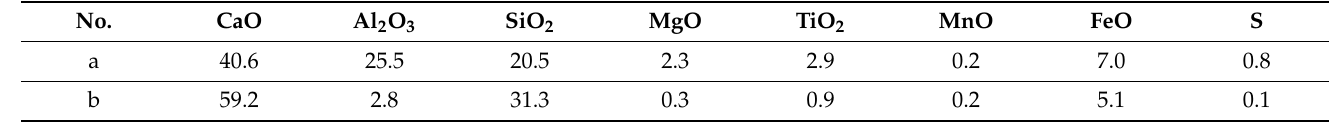
( b ) Figure 10. CaO-Al 2 O 3 -SiO 2 ternary phase diagrams.( a ) experimental data, ( b ) average data The CaO-Al 2 O 3 -SiO 2 and CaO-SiO 2 inclusions’ compositions at different stages were projected into ternary phase diagrams of CaO-Al 2 O 3 -SiO 2 , as shown in Figure 10. Since the inclusion composition of the industrial sample is distributed dispersedly (Figure 10a), the average composition of inclusions during different stages is shown in Figure 10b. The in- itial composition of the LF entry is located in the 2CaO ∙ SiO 2 region, and with the refining processing from LF → VD → TD → final products, the average composition moved from the 2CaO ∙ SiO 2 region to the 2CaO ∙ Al 2 O 3 ∙ SiO 2 region (Gehlenite) and eventually returned to the 2CaO ∙ SiO 2 region (Ca 2 SiO 4 ). First, additive lime during the BOF tapping process brought CaO into molten steel, and it met the primary deoxidization product SiO 2 and formed 2CaO ∙ SiO 2 . When Ti-Fe alloy was added, residual Al enterted the molten steel and formed the deoxidization product Al 2 O 3 . The combination of Al 2 O 3 and Ca 2 SiO 4 formed 2CaO ∙ Al 2 O 3 ∙ SiO 2 , and significantly decreased the liquidus of inclusion. Then, Ca treatment led to the reduction of Al 2 O 3 and SiO 2 in 2CaO ∙ Al 2 O 3 ∙ SiO 2 , so the Al 2 O 3 and SiO 2 content kept dropping while the CaO content gradually increased. When LF began, the average inclusion composition located in the 2CaO ∙ SiO 2 region and the CaO/SiO 2 ratio was about 1.7–1.8, and its liquidus was around 2000 °C. After the Ti addition, the average